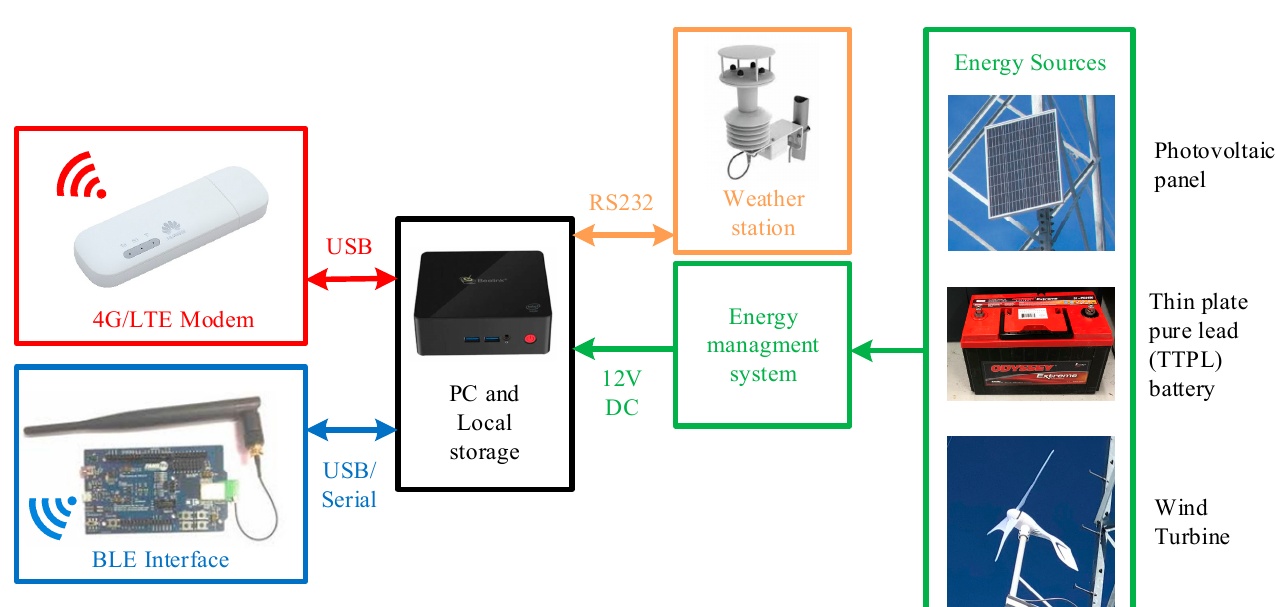
Figure 8. Block diagram of the devices composing the gateway.